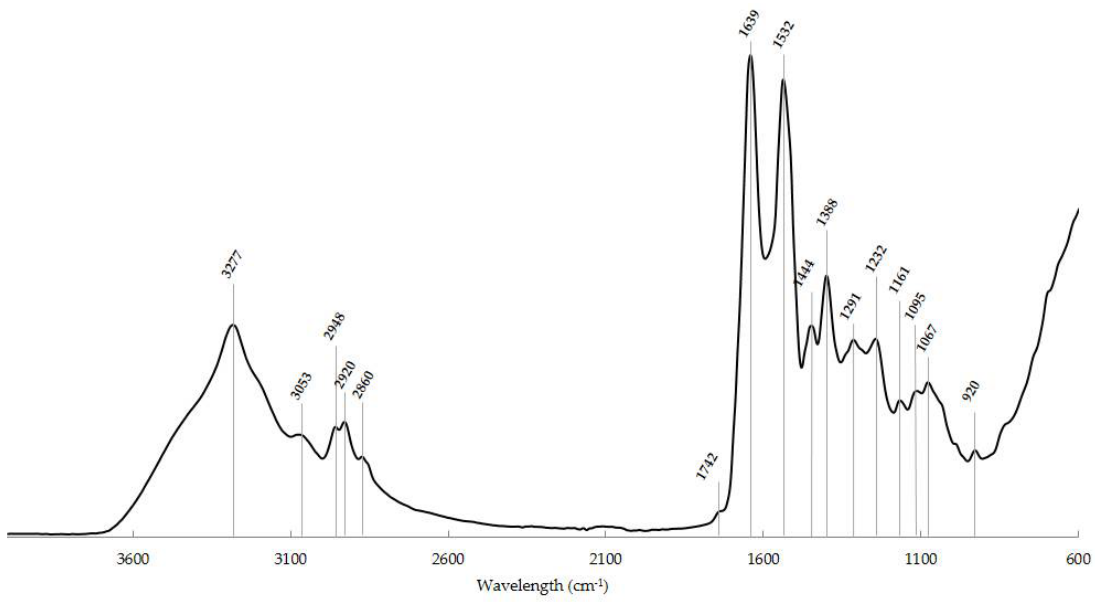
Figure 1. Typical IR spectrum of a normal thyroid cytological sample in the ~4000−600 cm −1 region with the main spectroscopic signals. X-axis: wavenumber (cm −1 ); Y-axis: arbitrary units (a.u.). Table 2 . Spectral peaks and the corresponding biochemical components and vibrational modes of a typical normal thyroid cytological sample obtained by FNA. Adapted from [47,73,78,86,88,91]. Wavenumber (cm −1 )